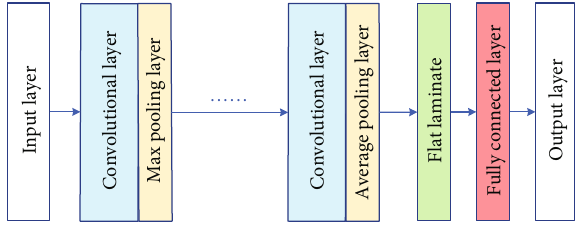
Figure 6: The structure of the convolutional neural